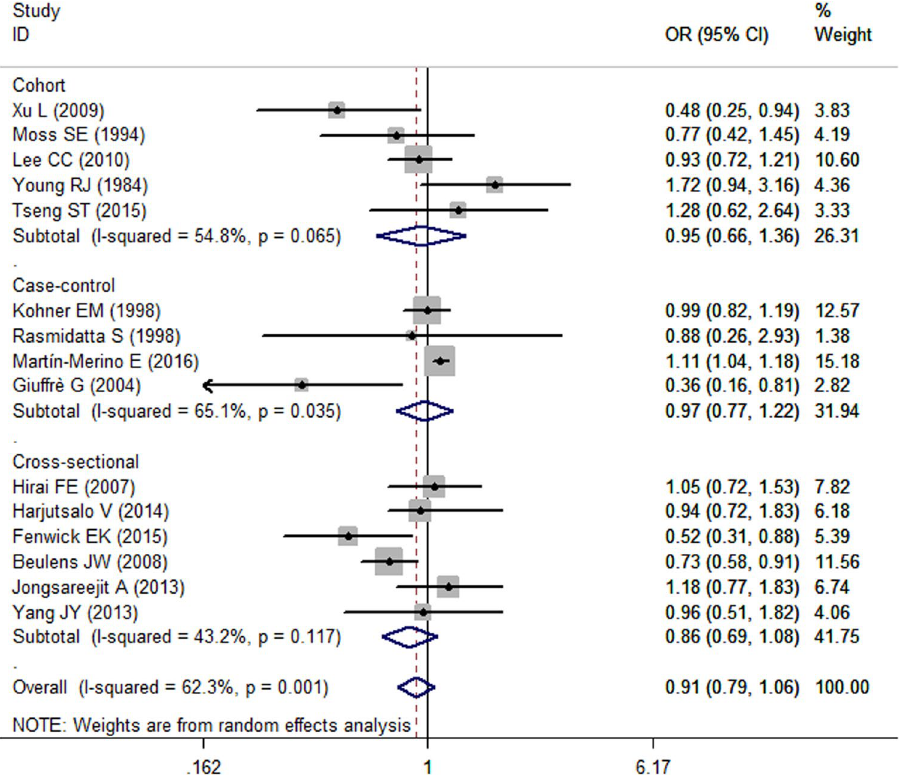
Figure 2. Summary of the odds ratios for the association between alcohol intake and the risk of DR by study designs. Through subgroup analyses, no significant association was detected in cohort, case-control or cross- sectional studies. The size of the shaded square is proportional to the percent weight of each study. Horizontal lines represent 95% CIs. The diamond data markers indicate pooled